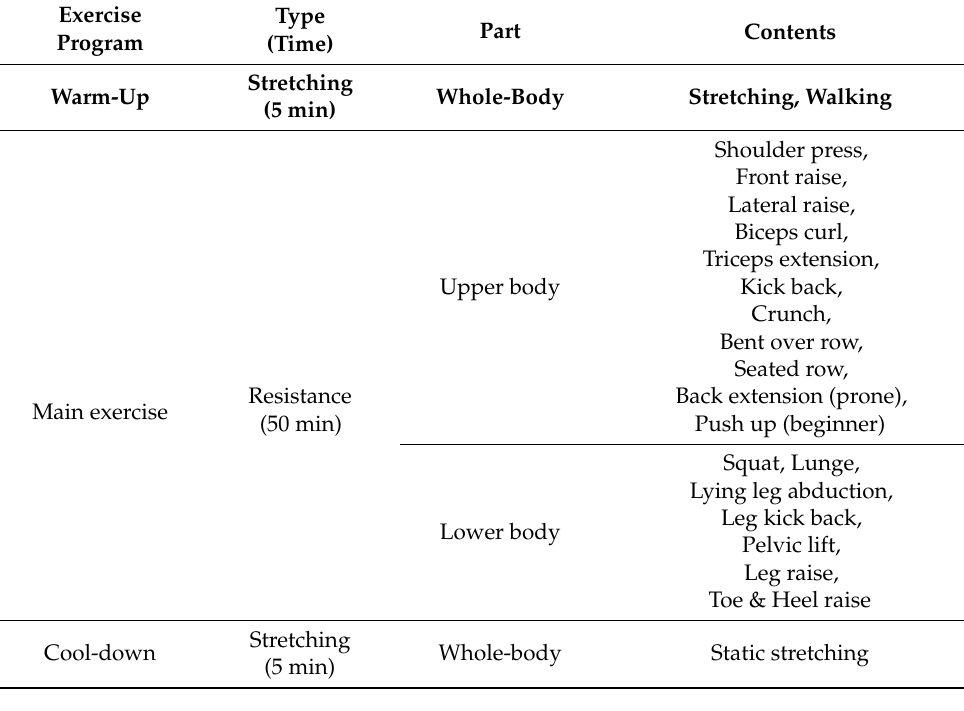
Table 3. Training